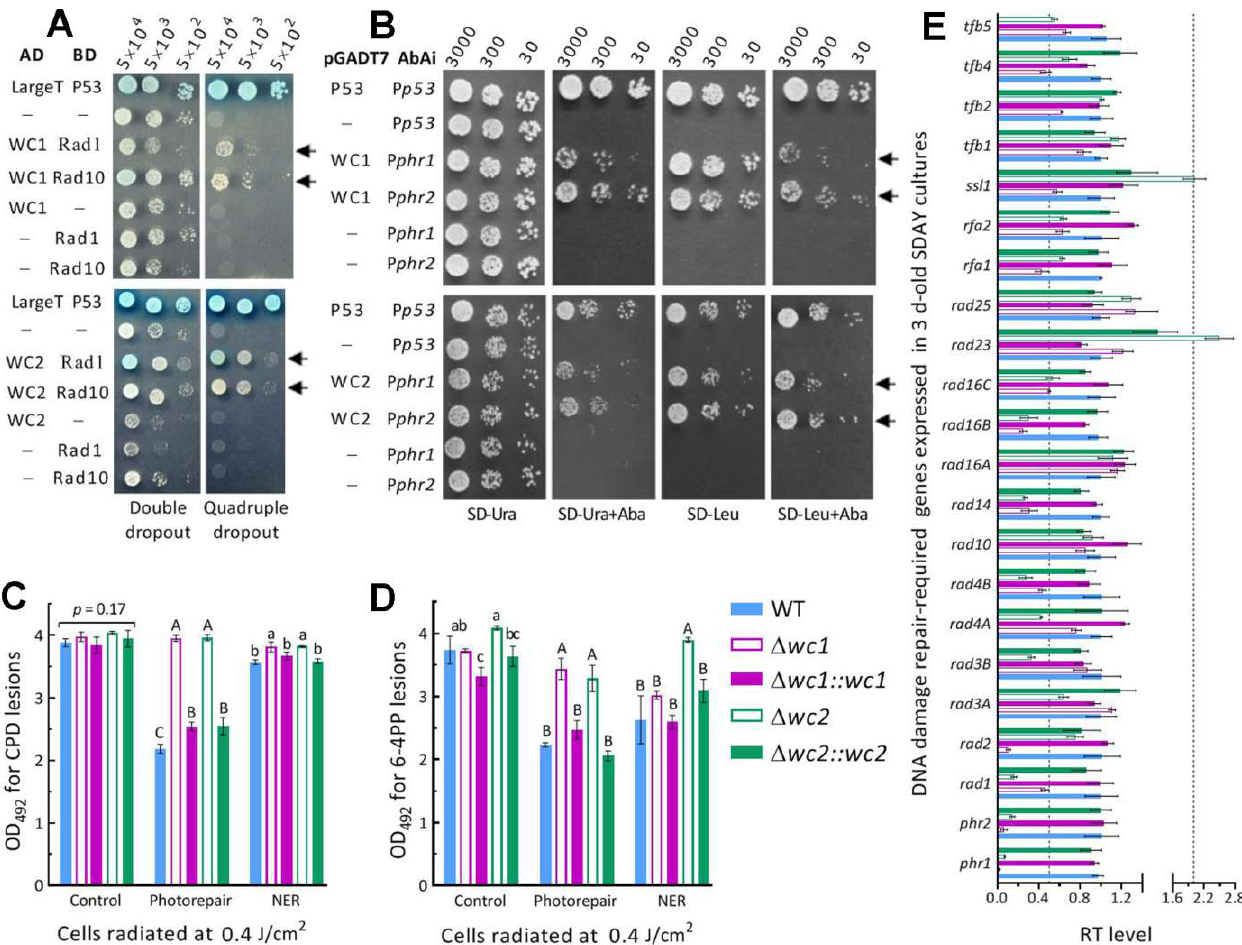
Figure 4. Rad1 and Rad10 interact with WC1 and WC2 serving as regulators of Phr1 and Phr2 in B. bassiana . ( A ) Y2H assays for interactions of either Rad1 or Rad2 with both WC1 and WC2. Note that the constructed diploids (arrowed) grew well like the positive control, AD-LargeT-BD-P53, on the quadruple-dropout medium during a 3-day incubation at 30°C after initiation of colony growth by the indicated numbers of cells. ( B ) Y1H assays for the activities of WC1 and WC2 binding to the DNA fragments of P phr1 and P phr2 . Note that the arrowed constructs grown on different media at 30°C indicate positive binding activities of WC1 or WC2 to both P phr1 and P phr2 . ( C , D ) The OD 492 readings for the amounts of CPD and 6-4PP DNA lesions accumulated in the hyphal cells of ∆ wc1 , ∆ wc2 , and their control strains incubated at 25 ◦ C for 5 h under white light (photorepair) and in the dark (NER), respectively, or not incubated (control) after impaired at the UVB dose of 0.4 J/cm 2 . The CPD and 6-4PP OD 492 values were read from 50 μL reaction systems containing 20 and 200 ng DNA samples probed by anti-CPD and anti-6-4PP antibodies in a 96-well ELISA plate, respectively. Different lowercase or uppercase letters in each bar group denote significant differences of p <0.05 or 0.01 (Tukey’s HSD tests). ( E ) Relative transcript (RT) levels of phr1 , phr2 , and 20 putatively NER-required genes in the 3-day-old SDAY cultures of wc1 and wc2 mutants with respect to the WT standard. Dashed lines indicate significant levels of one-fold down- and upregulation. Error bars: SDs from three independent replicates. Next, ELISAs with anti-CPD and anti-6-4PP antibodies were conducted to assess the accumulated CPD and 6-4PP lesions in the DNA samples isolated from irradiated hyphal cells of wc1 and wc2 mutants. The UVB irradiation at 0.4 J/cm 2 resulted in sim-